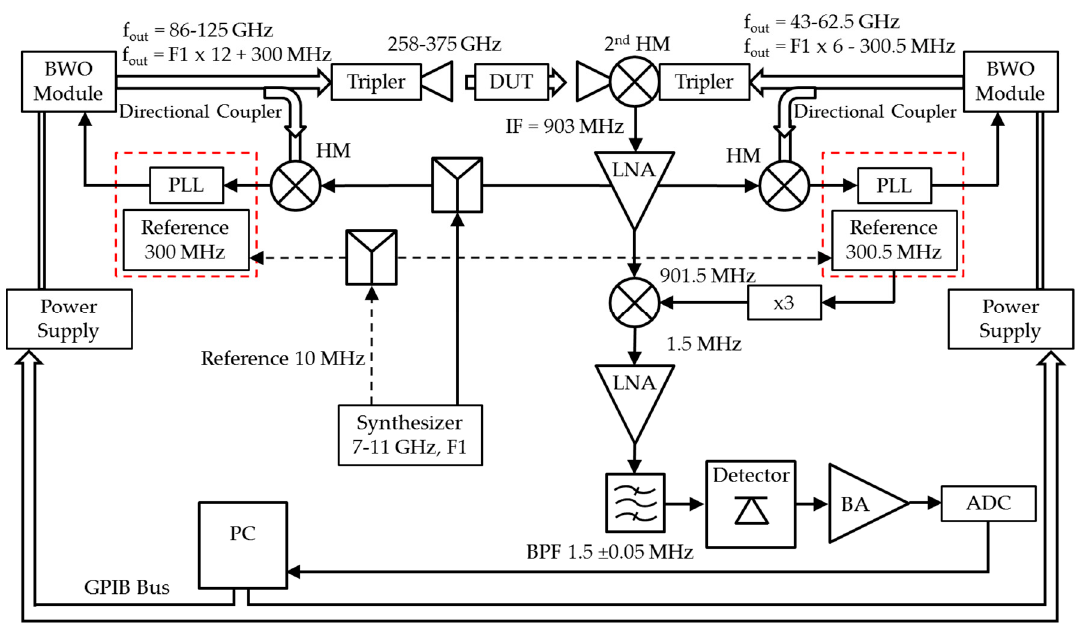
Figure 3. Schematic of the THz spectrometer.